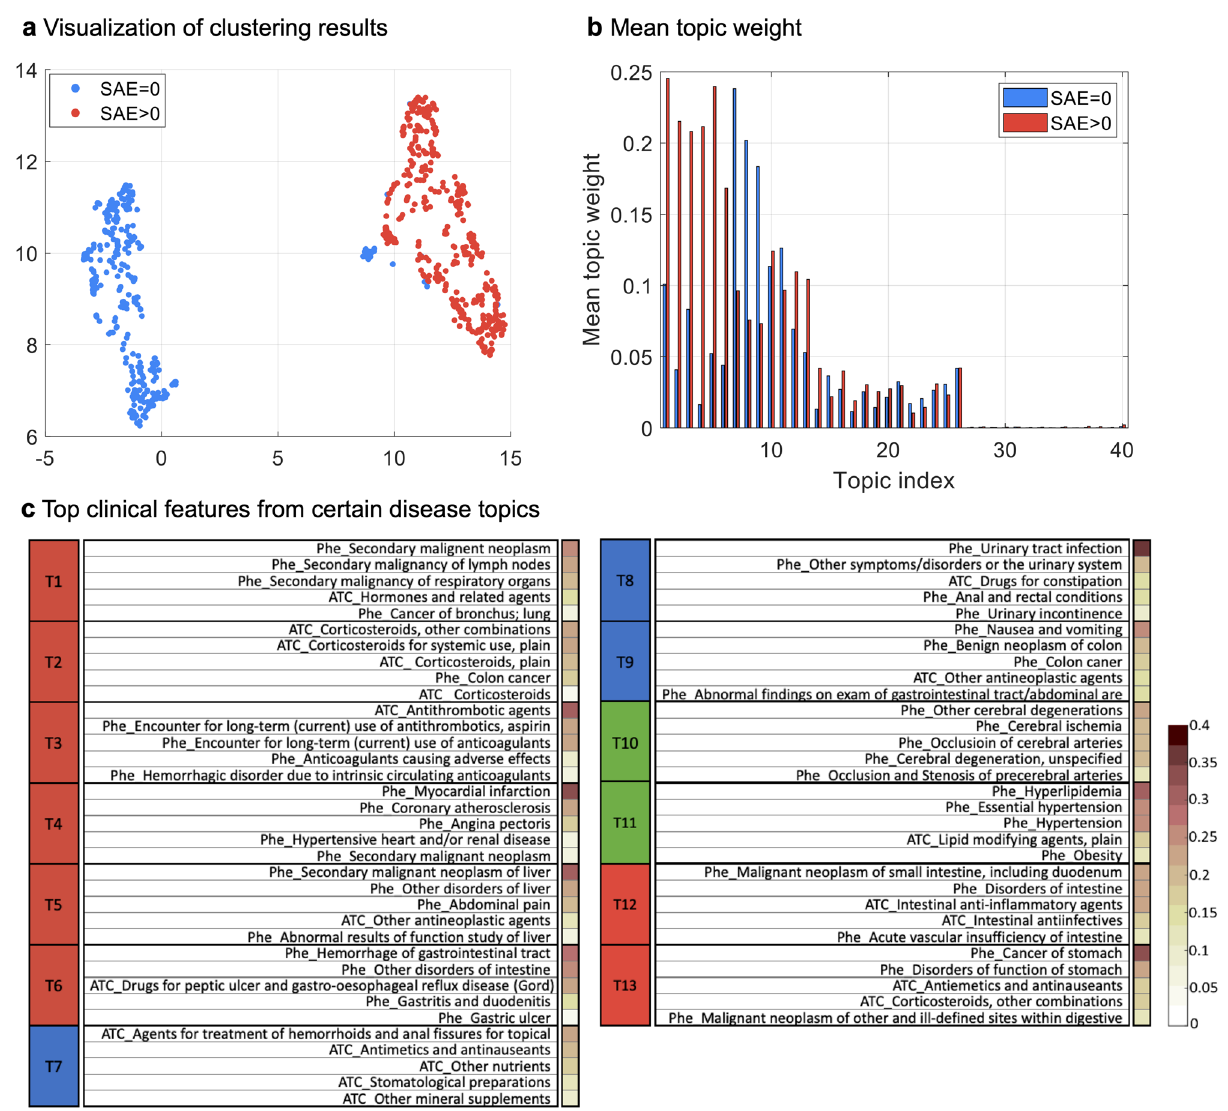
Figure 5. Clustering results of the CRC target population. ( a ) Visualization of clustering results. ( b ) Mean topic weight (MTW) of all topics on two groups, where the x-axis is the topic index and the y-axis is the MTW of each topic on two subgroups. ( c ) Top features from certain disease topics. The right sidebar of each topic shows the percentage of patients with the corresponding feature in that